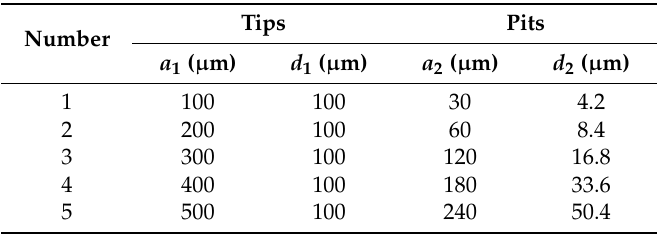
Table 1. The size details of the tips mask and pits